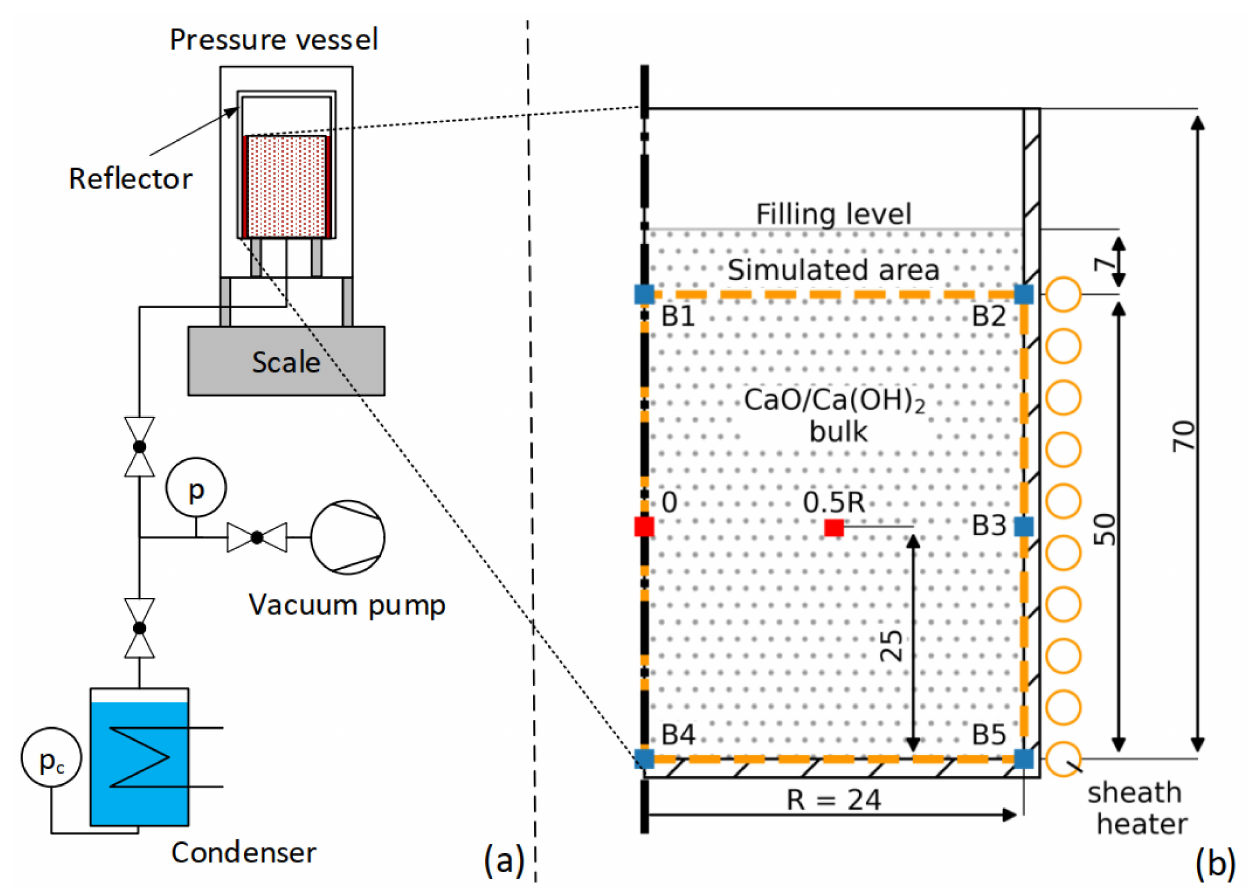
Figure 1. Schematic setup adapted with permission from ref. [35] ( a ), copyright 2019 John Wiley and Sons, and cross-section area of the reactor ( b ). Geometry values are given in mm. Blue and red squares are positions of